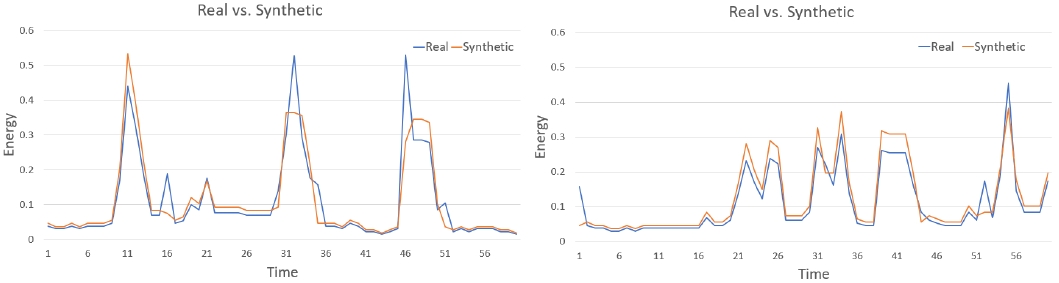
Figure 12. Two examples of generated data samples compared to real